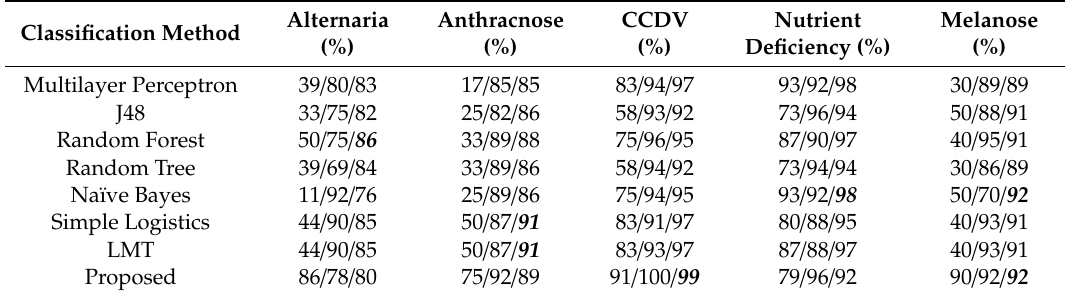
Table 6. Sensitivity / specificity / accuracy of the classification methods listed in the 1 st column, using the features presented in Table 1 (group A). The classification method with the best accuracy for each disease is highlighted with bold-italics.